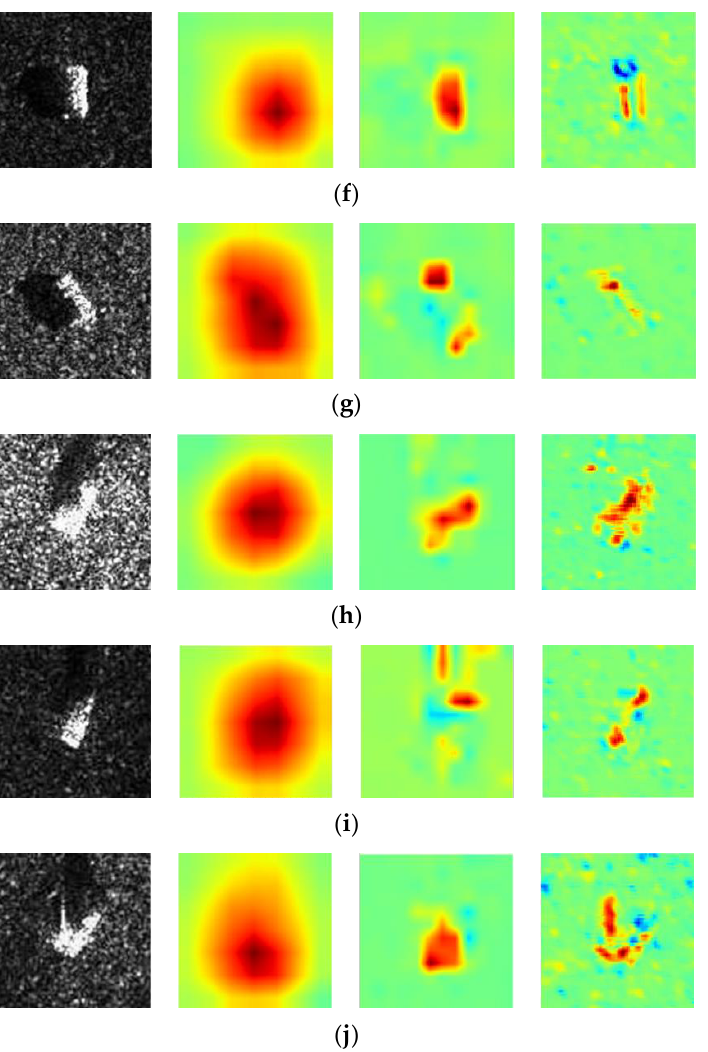
Figure 5. Comparison of various models for SAR images. The ten rows denote vehicles of different classes: ( a ) 2S1, ( b ) BRDM2, ( c ) BTR60, ( d ) D7, ( e ) T72, ( f ) BMP2, ( g ) BTR70, ( h ) T62, ( i ) ZIL131, ( j ) ZSU234.